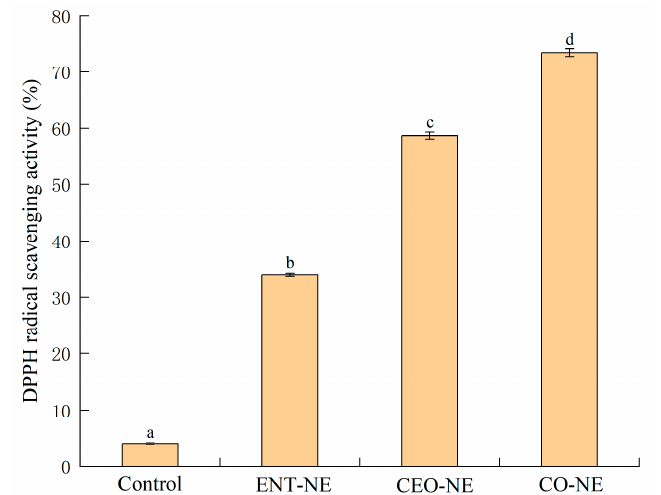
Values are expressed as means ± standard deviation. Columns with no lowercase letter in common for each treatment are significantly different ( p < 0.05). ND: not determined.